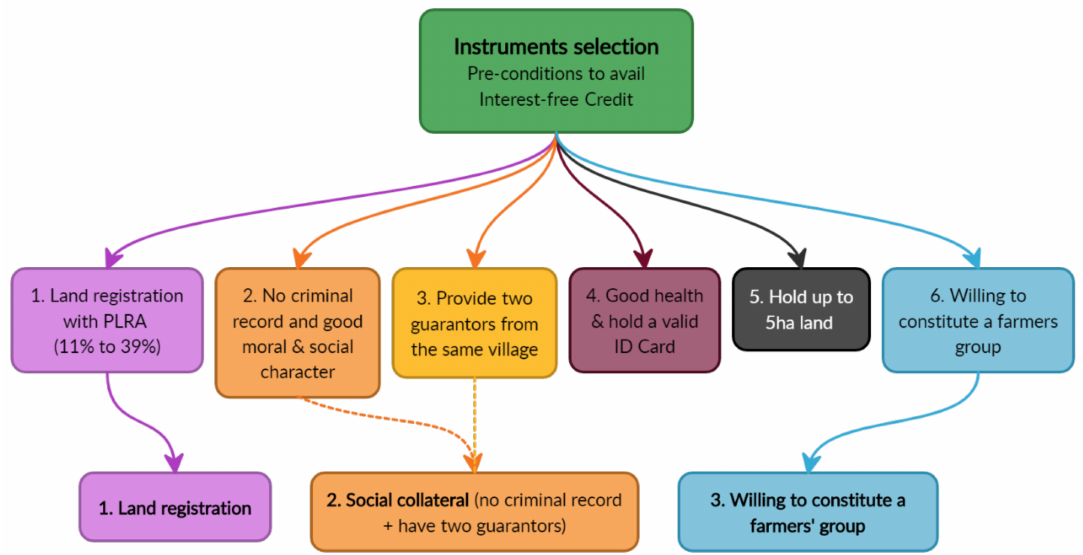
Figure 4. Credit participation pre-conditions and instrument(s)